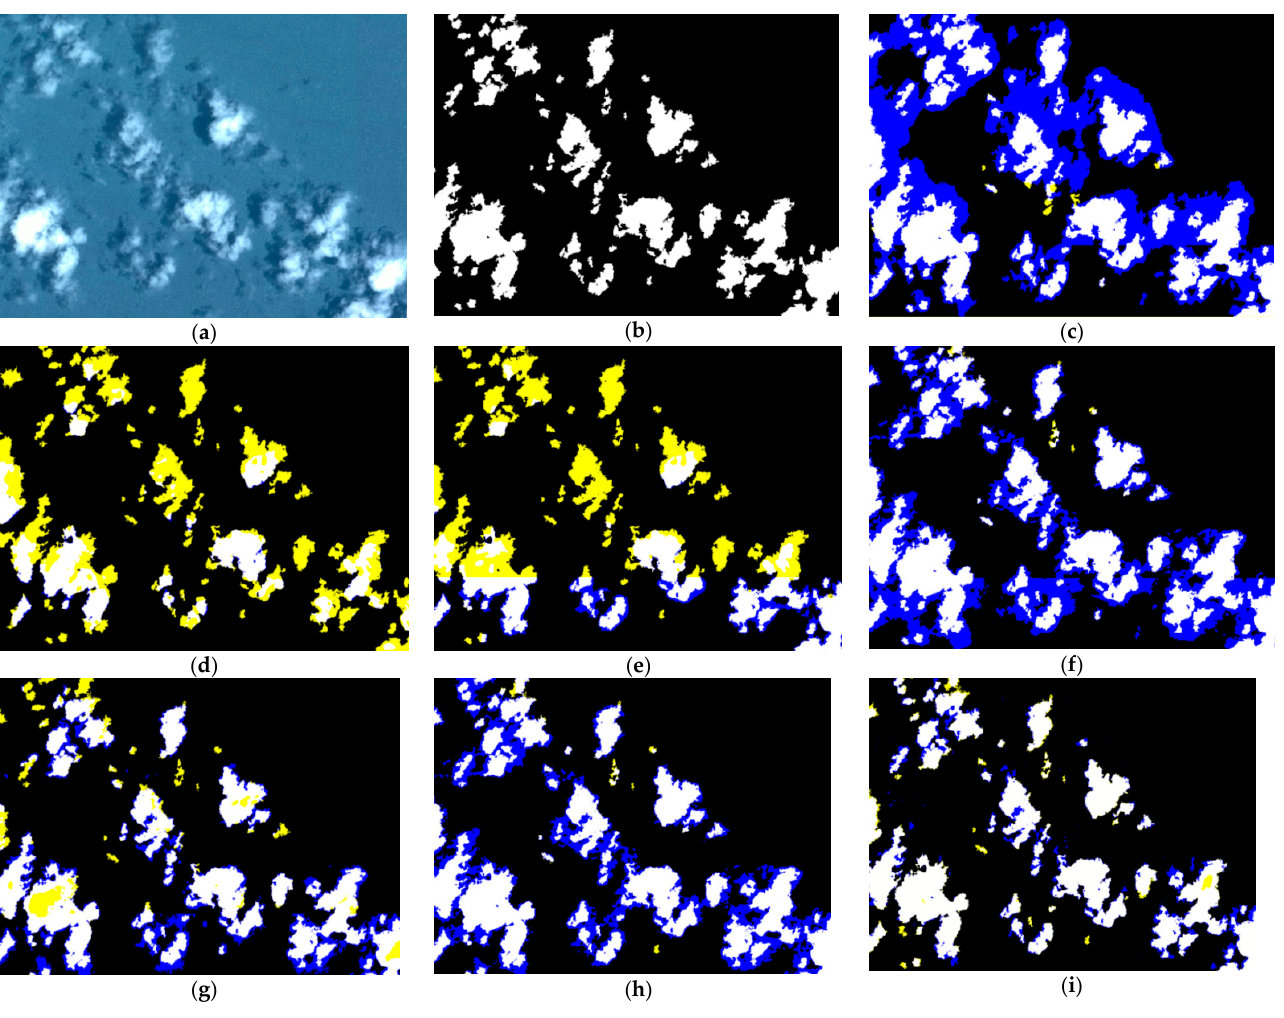
Figure 8. Detail comparison of different deep learning models at subregion B (the yellow areas indicate the missed extracted pixels and the blue areas indicate the wrong extracted pixels). ( a ) True color images. ( b ) ground truth. ( c ) DeeplabV3+. ( d ) MT-Unet. ( e ) MSCFF. ( f ) CDNet. ( g ) RS-net. ( h ) GCDB-Unet. ( i ) ours.